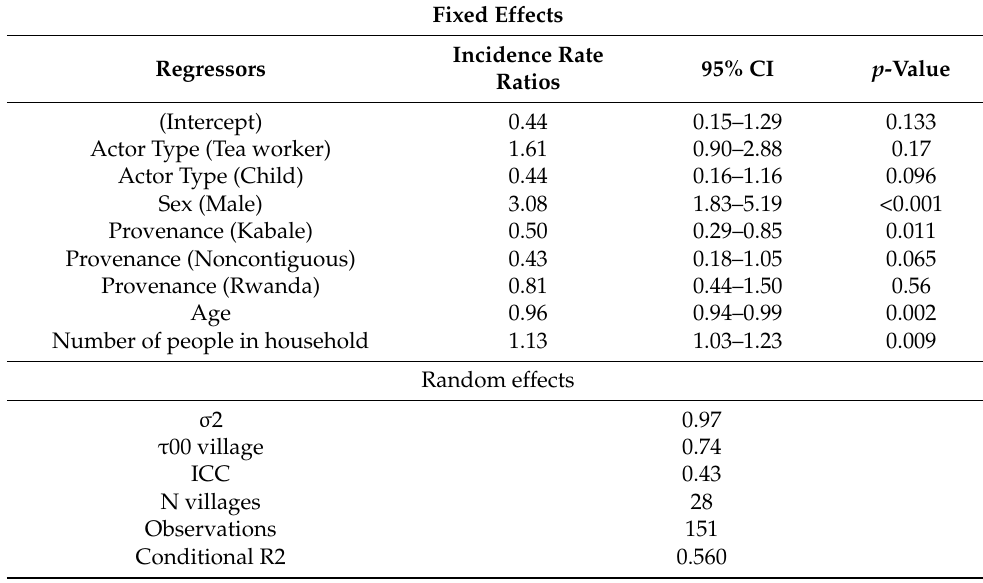
Table 3. Mixed Poisson model of wild meat consumption frequency in Sebitoli area, Kibale National Park,